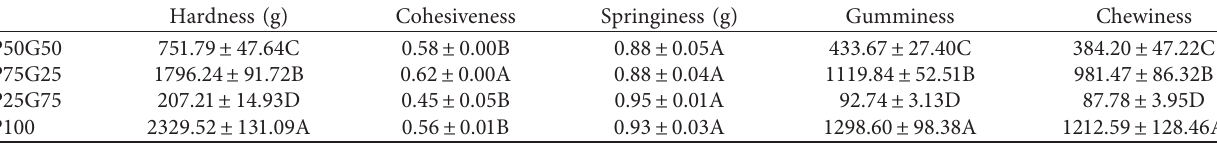
Table 4: The effects of pectin: gum ratio on textural properties of samples.